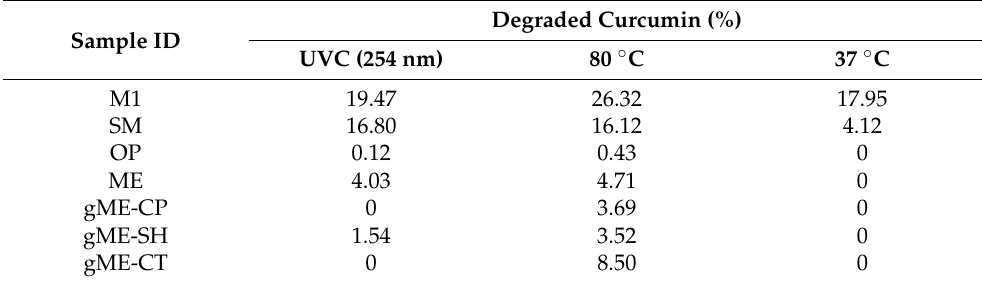
Table 2. The amount of curcumin degraded after 2 h, after exposure at UVC, 37 ◦ C, and 80 ◦